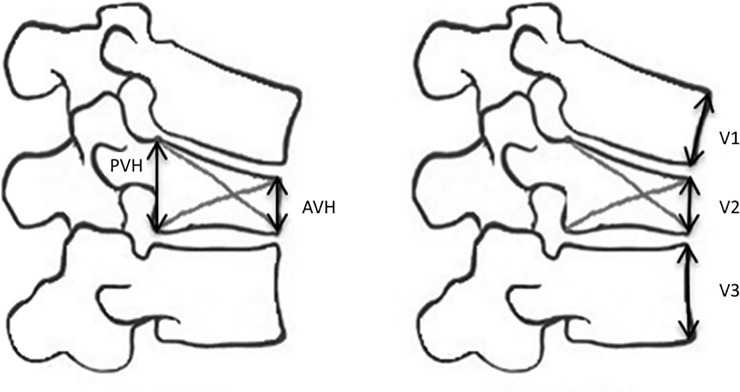
Radiographic measurements.Measurement of VBCR (VB compression rate) = AVH/PVH, AVH anterior vertebral height, PVH posterior vertebral height; Measurement of AVBC% (Anterior VB compression percentage) = V2/[(V1+V3)/2]x100% [19].